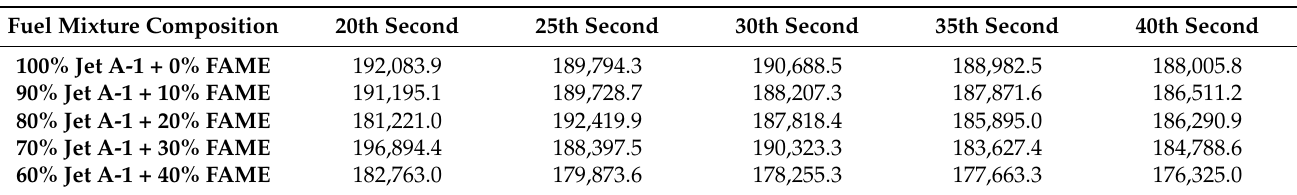
Figure 11. The graphical course of changes in the total air pressure in front of the gas turbine SJE-20 p 3t when using different mixtures of Jet A-1 aviation kerosene and FAME biofuel. Table 13. Change in total gas pressure in front of gas turbine p 3t [Pa] SJE-20 with different concentrations of jet A-1 aviation kerosene and FAME biofuel.